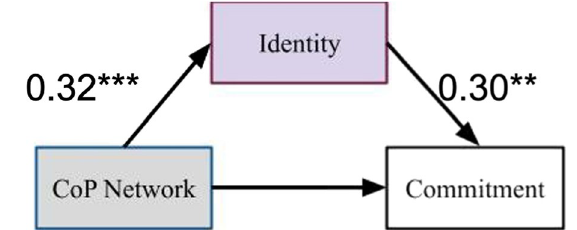
Fig. 5 Structural equation model showing the paths between network bridging, identity, and commitment